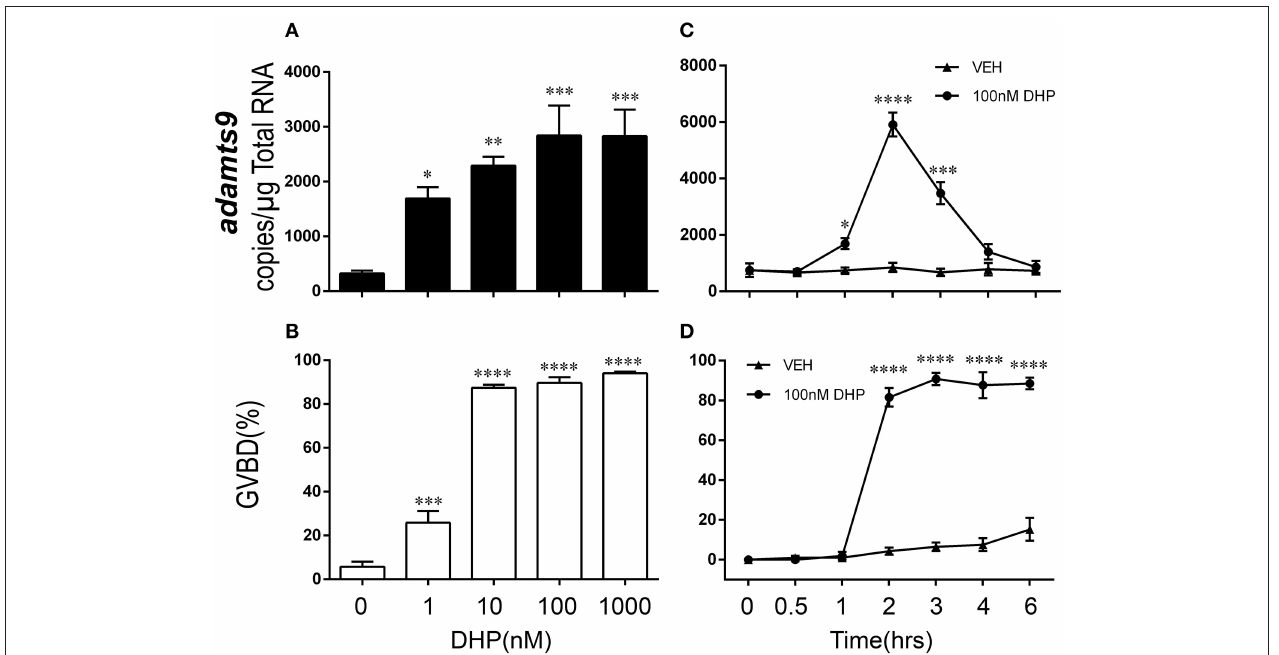
FIGURE 6 | Dose- and time-dependent and transient increase of adamts9 in stage IV follicles exposed to progestin in wildtype ( wt ) zebrafish in vitro . (A,B) Effects of various doses of progestin (17 α ,20 β -dihydroxy-4-pregnen-3-one, DHP) on the expression of adamts9 transcript and oocyte maturation, i.e., germinal vesicle breakdown (GVBD) during in vitro incubation. (C,D) Effects of DHP (100nM) on adamts9 expression and GVBD at various time points of in vitro incubation. Asterisks indicate significant difference in hormone treated samples compared to vehicle treatment at the same time point. * p < 0.05, ** p < 0.01, *** p < 0.001, **** p < 0.0001. Experiment was repeated three times with results of one representative experiment presented as mean ± SEM. N = 4.